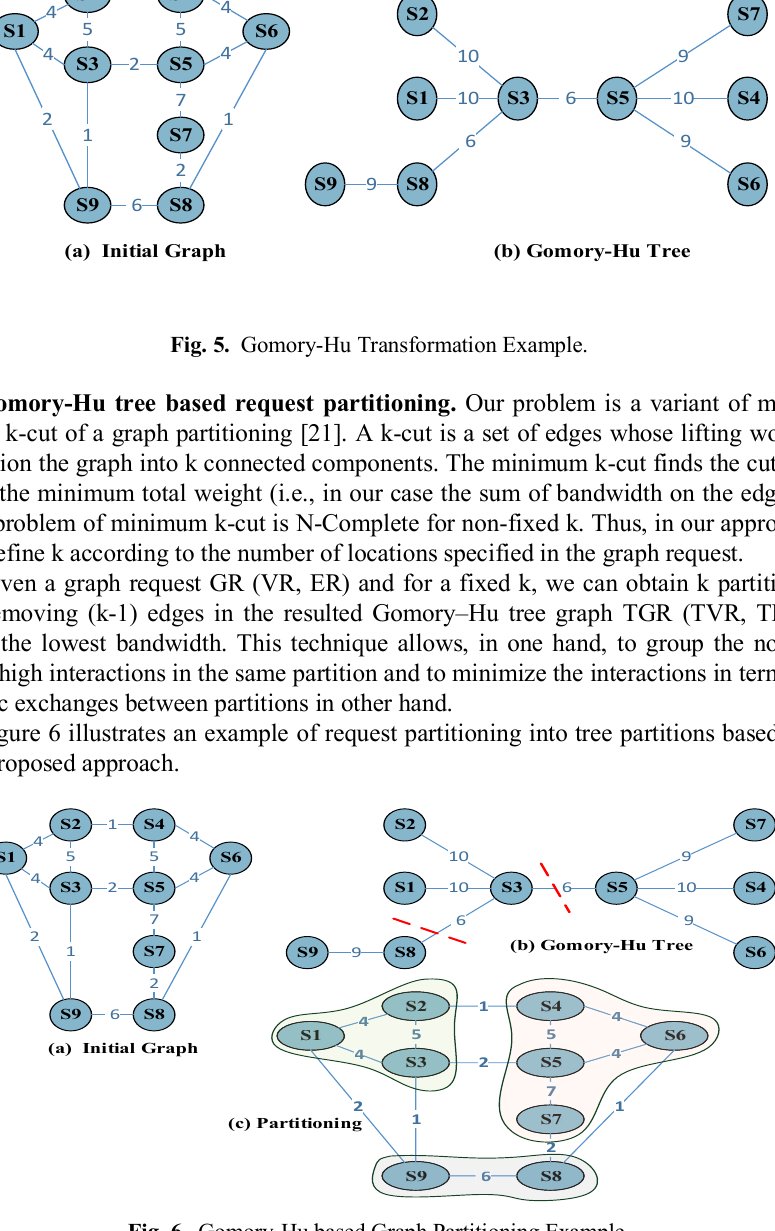
Fig. 6. Gomory-Hu based Graph Partitioning